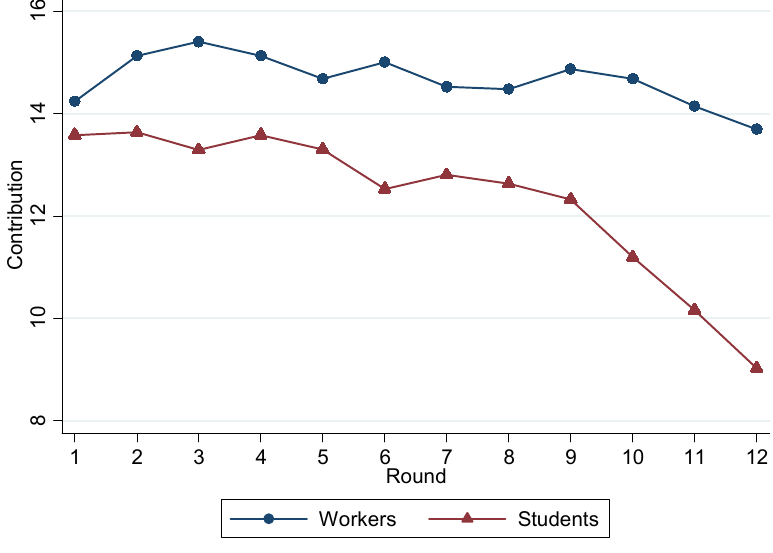
Figure A4. Evolution of average contributions over